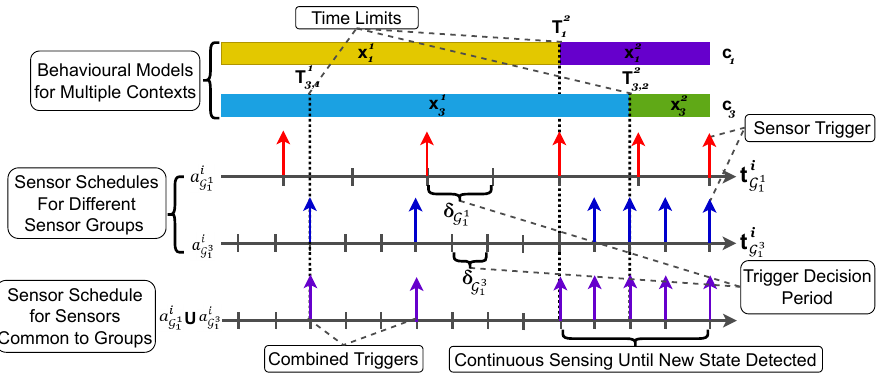
Figure 4. An illustration of the triggering decision interval, sensing schedules, and synchronization procedure of 2 sensor groups used to recognize different contexts while having a common